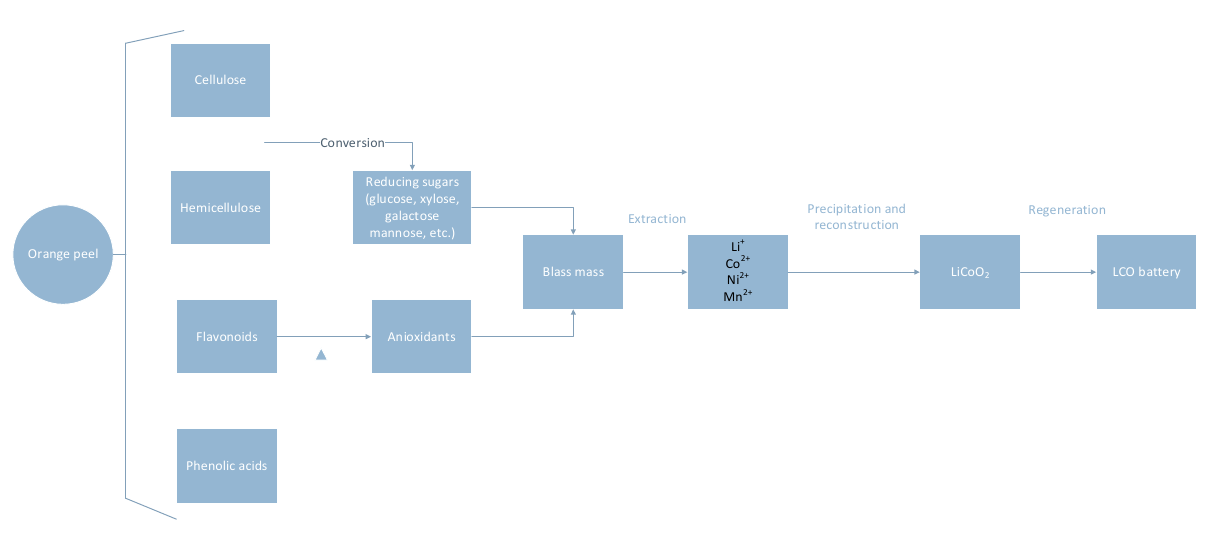
Figure 8. Mechanism and process summary of recycling of spent LIBs using orange peel (), redrawn from Wu, Soh, Chan, Meng, Meyer, Srinivasan and Tay [62].